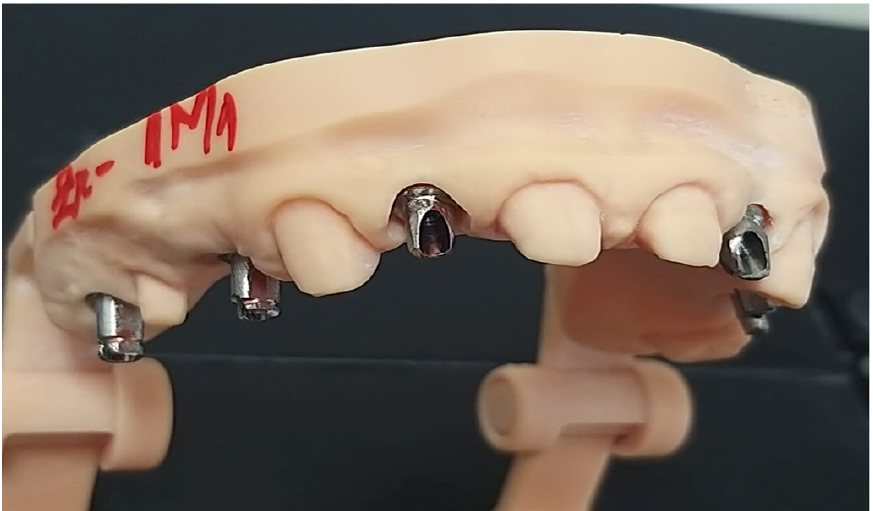
Figure 3. The printed working cast with the stock milled abutments, ready to be tested in the oral cavity.